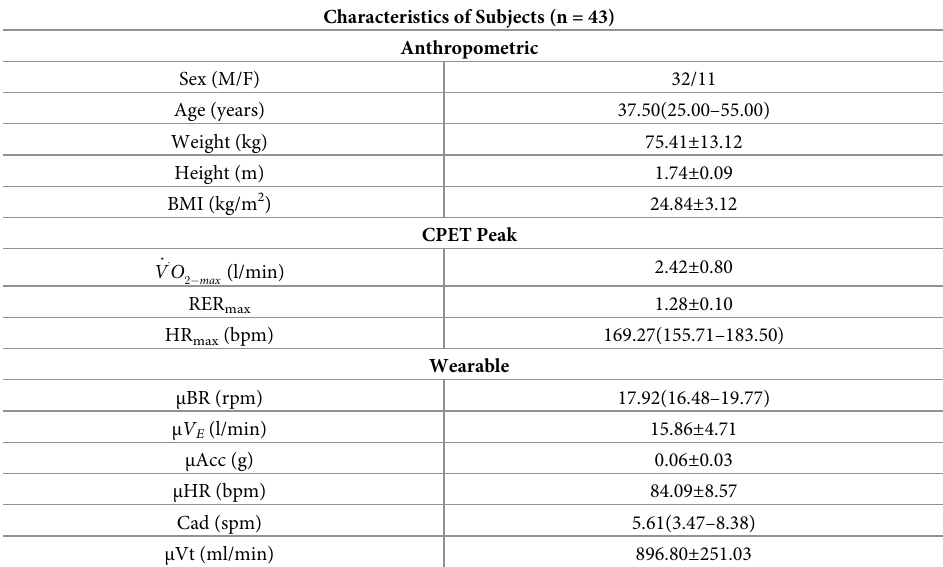
Table 1. Characteristics of volunteers, peak variables obtained during the cardiopulmonary exercise testing, and the mean response of the variables obtained by the